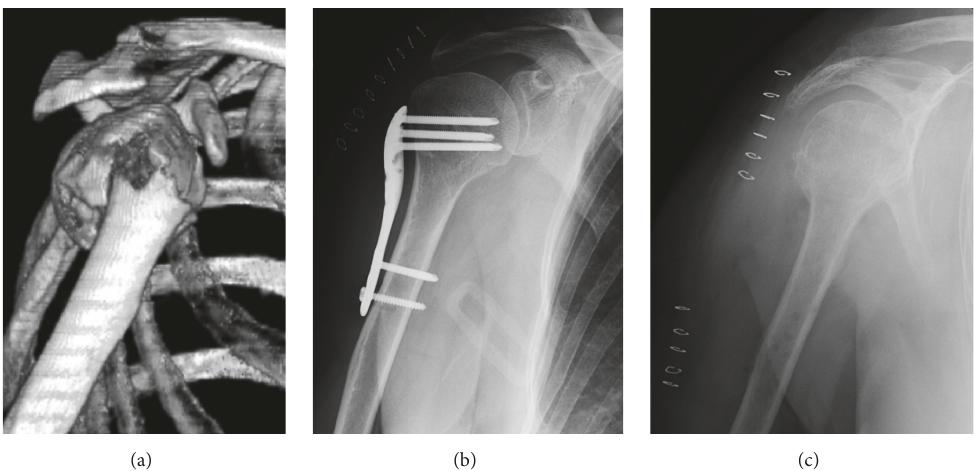
Figure 3: (a) Two-part varus nonimpacted fracture of the surgical neck (AO/OTA type A3) in a 57-year-old woman. (b) Postoperative radiogram: the plate was not flush with the bone surface and caused painful impingement during rehabilitation. (c) Three months after fixation the plate was removed; the fracture healed uneventfully.